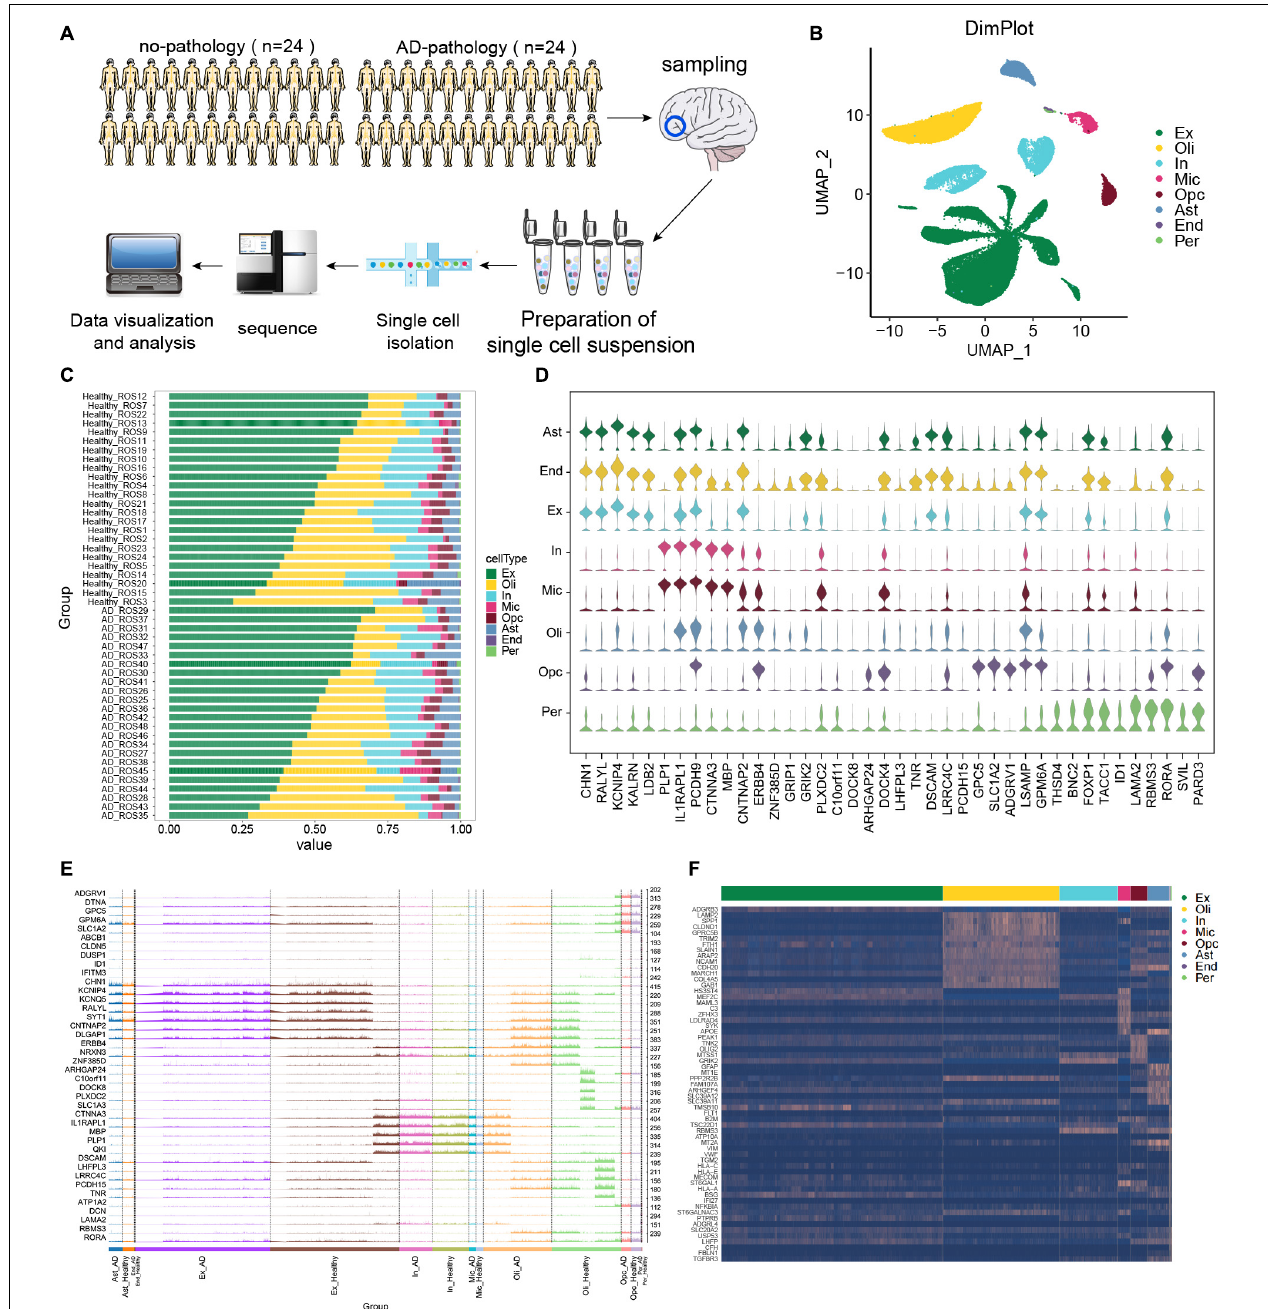
FIGURE 1 | Single-cell transcriptomic landscape of brain tissue from individuals showing strong Alzheimer’s disease pathology (“AD-pathology”) or weak or no pathology (“no-pathology”). (A) Study cohort and sample analysis. (B) Annotated single-cell profiles of the samples. Eight cell types were identified: excitatory neurons (Ex), oligodendrocytes (Oli), inhibitory neurons (In), microglia (Mic), oligodendrocyte progenitor cells (Opc), astrocytes (Ast), endothelial cells (End) and pericytes (Per). (C) Variations in cellular components. (D) Expression of the top 5 marker genes for each cell type in no-pathology patients. (E) Differences in expression of the top 5 marker genes in each cell type between AD-pathology and no-pathology individuals. High peaks indicate higher expression, while low peaks indicate lower expression. (F) Heat map showing marker genes specifically expressed in each cell type in the AD-pathology